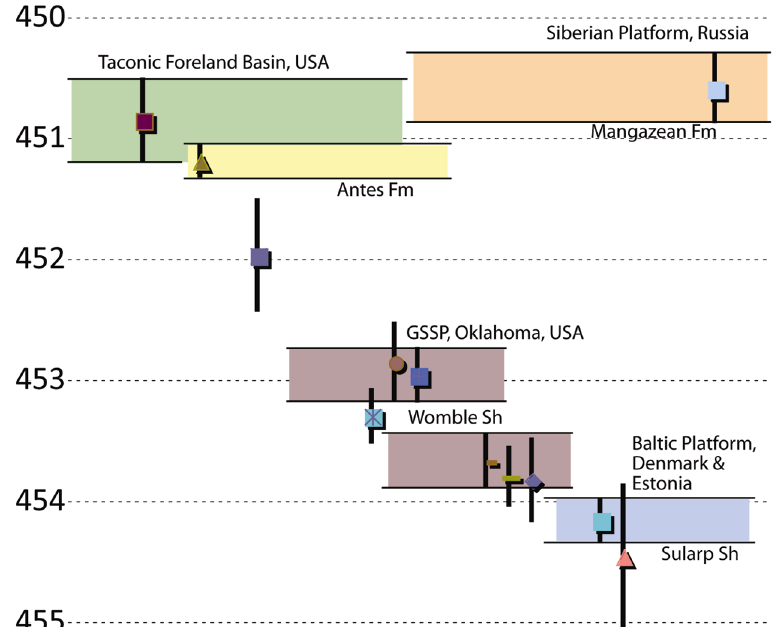
Fig. 3. Comparison of the U/Pb ages of zircons from the Siberian Platform and the Taconic Foreland Basin plus comparative ages from Ordovician beds in Oklahoma and the Baltic Platform. The 454 Ma age represents the Kinnekulle K-bentonite. The symbols represent the exact age measurement for each sample and the colored zones represent the error margins.